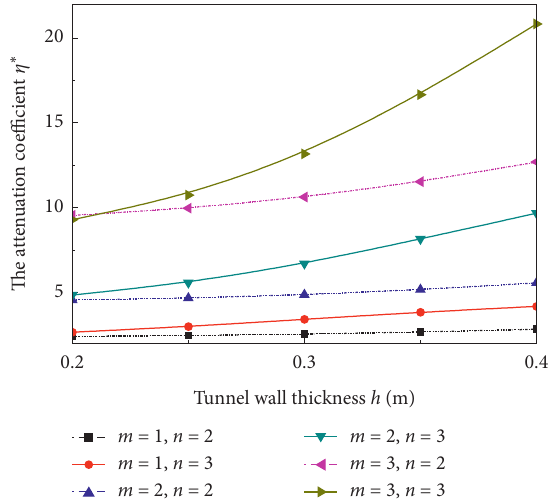
Figure 5: Relationship between attenuation and changes in the tunnel radius for different modes, where η � 1.0 × 10 6 Pa · s.